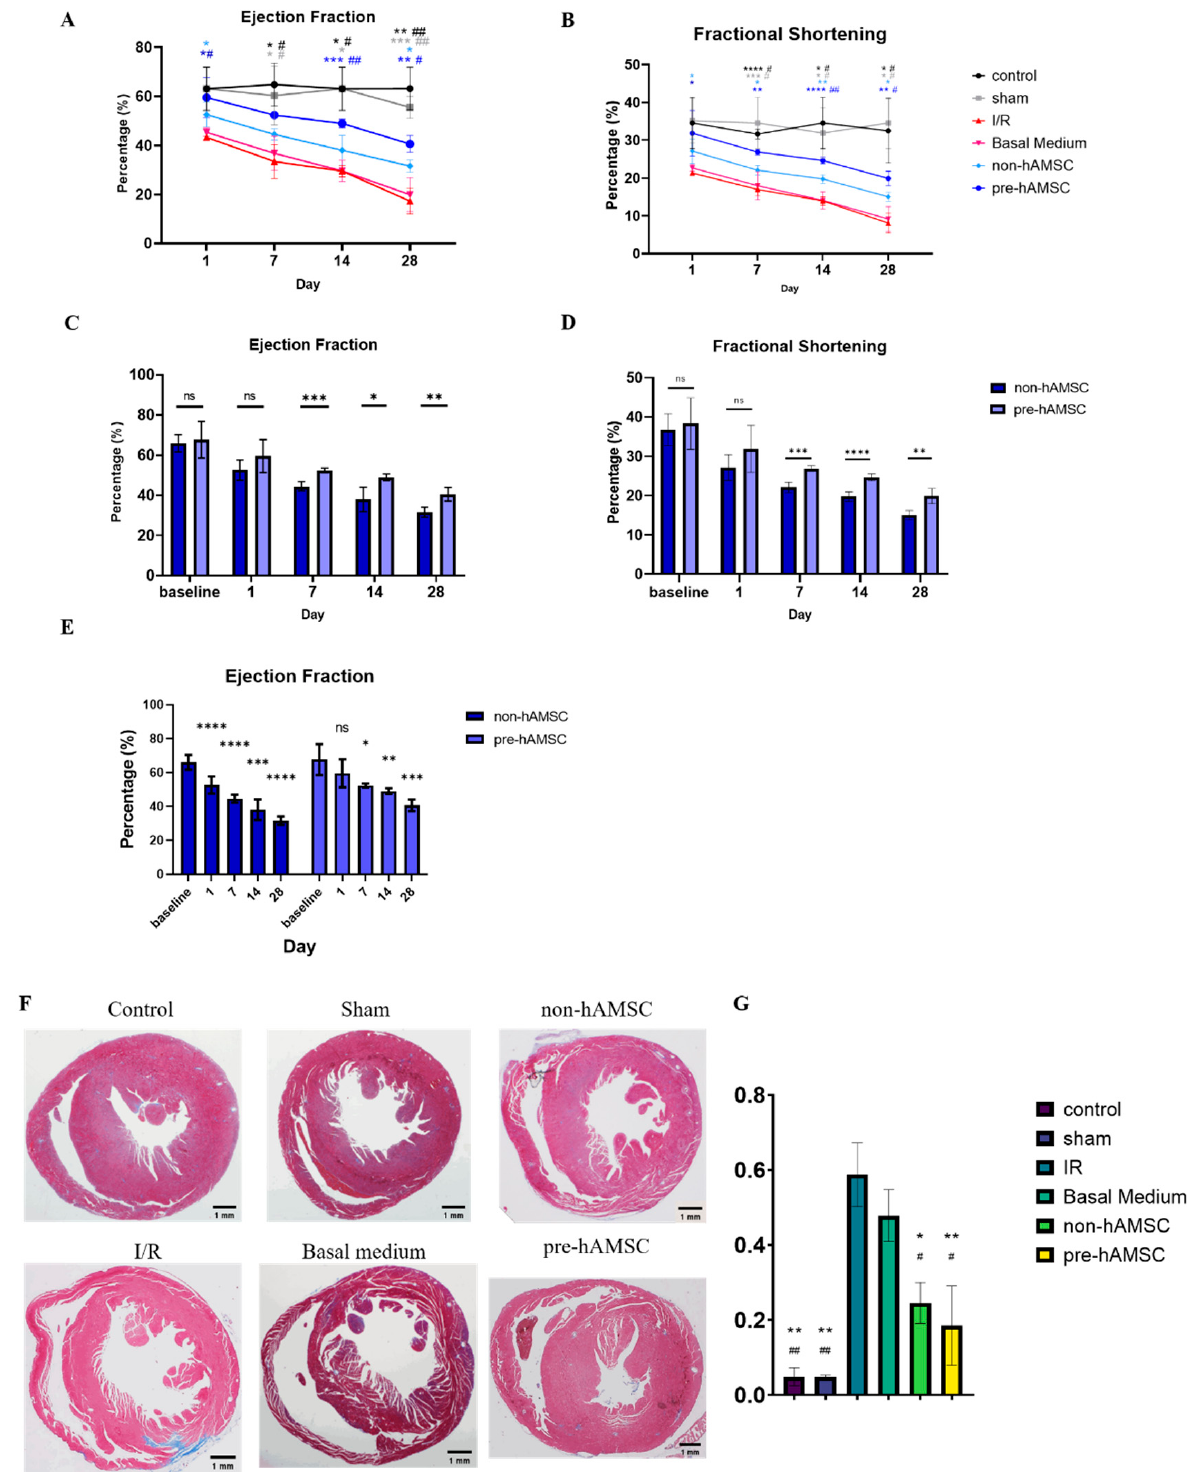
Figure 6. Cardiac function and fibrosis in each group during the 4-week period after the I/R injury. LVEFs ( A ) and FS ( B ) of control, sham, I/R, basal medium, non-hAMSC, and pre-hAMSC groups. ( C – E ) Representative bar graphs of left ventricular function in non-hAMSC and pre-hAMSC groups. ( F ) Masson’s Trichrome staining of histological transverse sections of hearts in each group 28 days after the I/R injury (Bar = 1 mm). ( G ) Quantification of heart fibrosis area in each group at 28 days after I/R surgery via Masson’s Trichrome staining. * Comparison with I/R group. * p < 0.05, ** p < 0.01, *** p < 0.001, **** p < 0.0001. # Comparison with Basal Medium group. # p < 0.05, ## p <